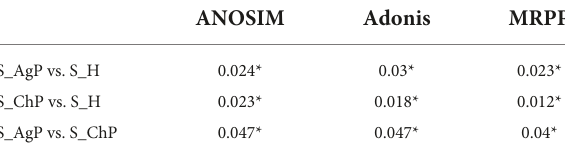
TABLE 3 Differences in metabolome among the three groups ( p